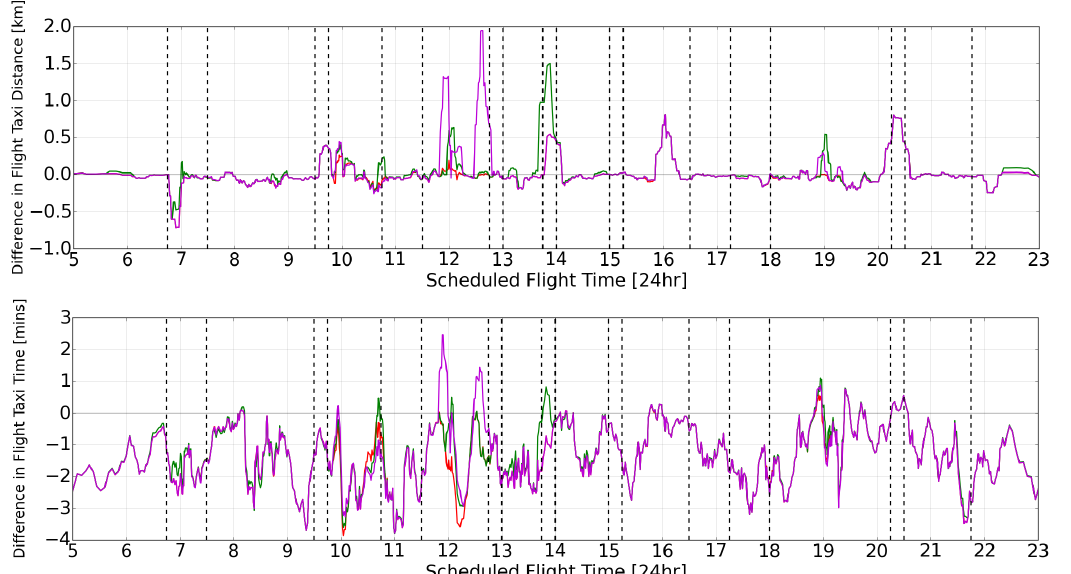
Figure 9. Moving average differences with respect to the real-world data, grouped per 10 flights for the MAS simulation of 2 May 2016. Red line: CBS mechanism performance, green line: CBS + MP HWYs mechanism performance, purple line: CBS + CB HWYs mechanism performance. Dotted vertical lines represent runway reconfiguration